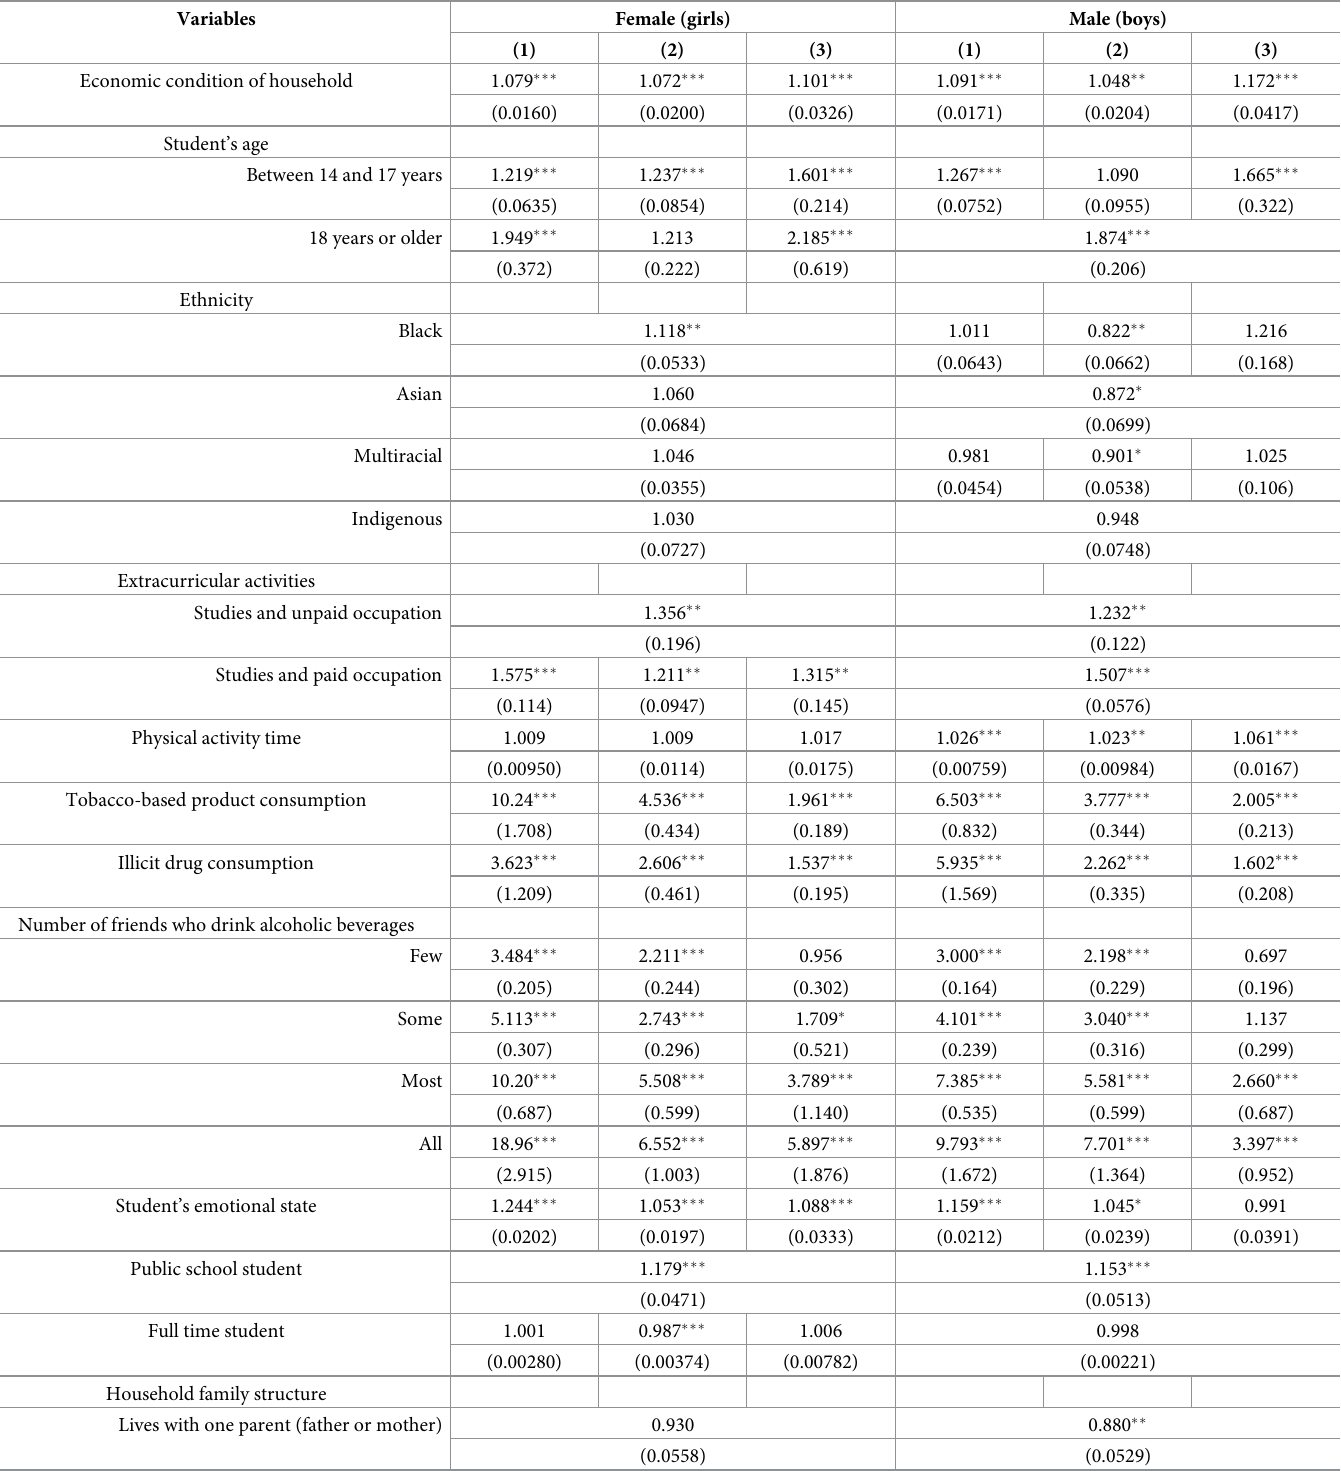
Table 3. Results of the sequential logit model (in odds